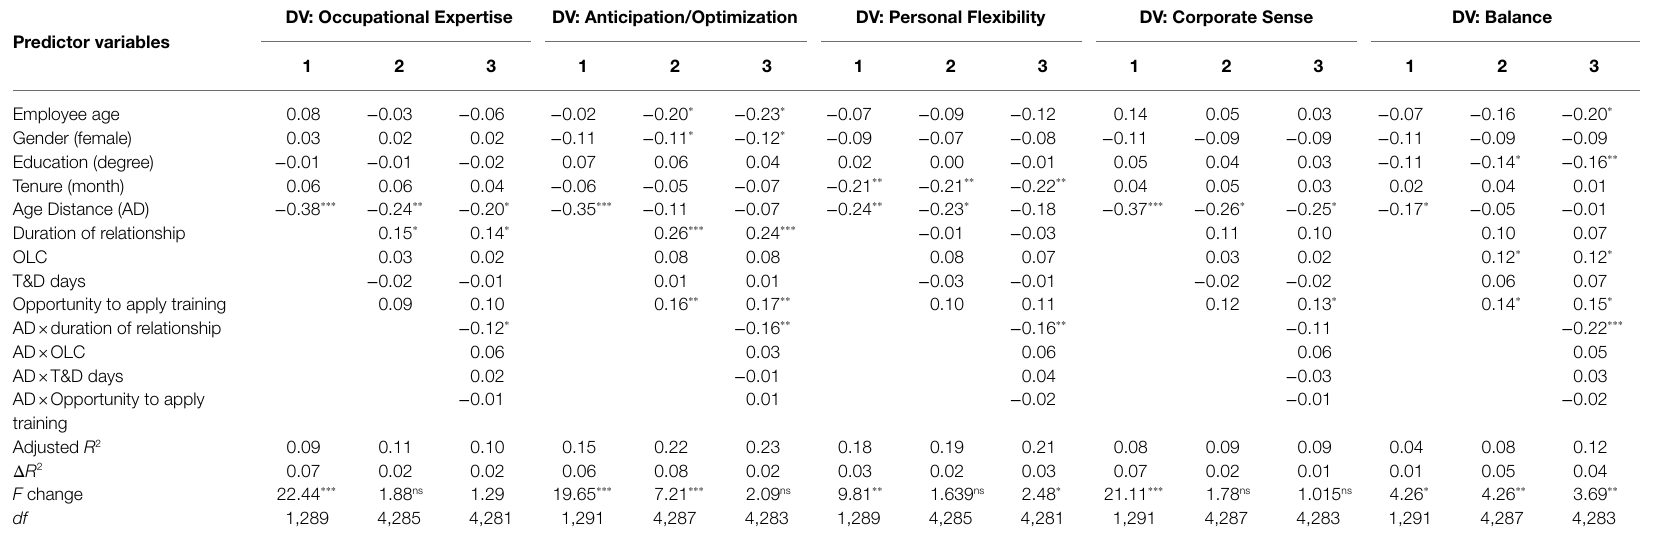
TABLE 2 | Hierarchical regressions for supervisory ratings of five dimensions of employability.